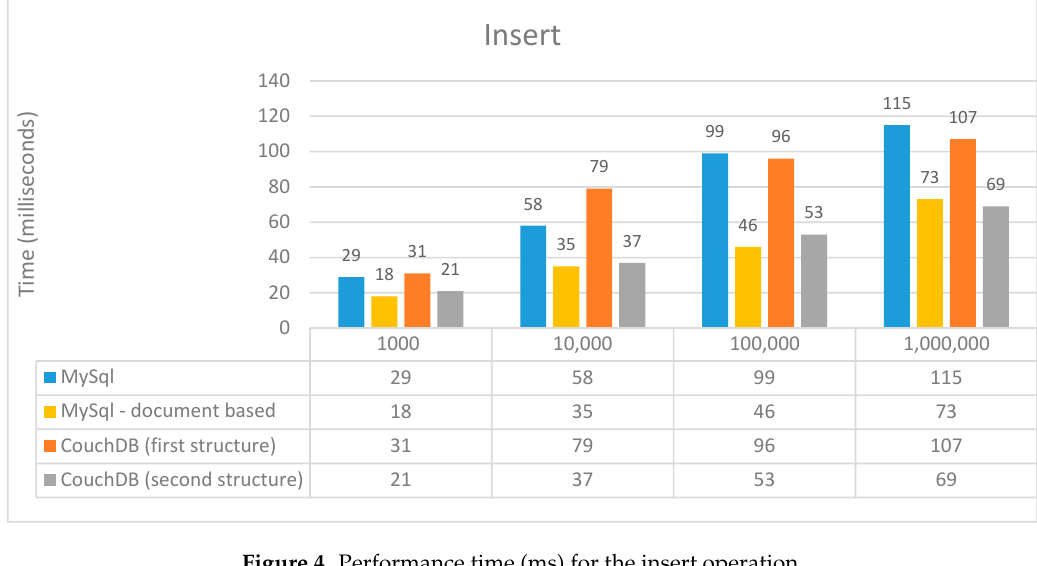
Figure 4. Performance time (ms) for the insert operation.